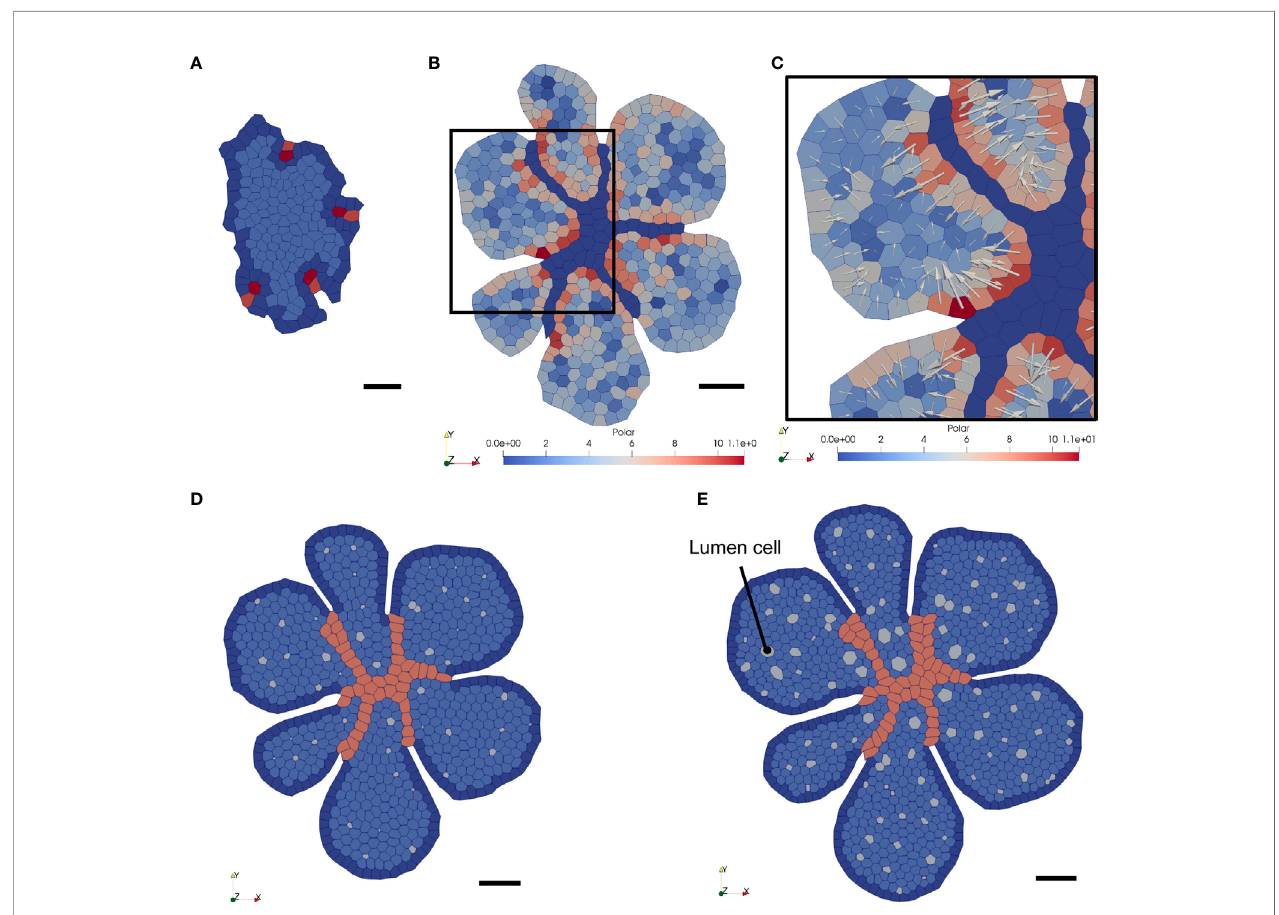
FIGURE 7 | Snapshots of the VM simulation of epithelial polarisation and lumen formation in the growing thyroid epithelial sheet invaded by endothelial cells. (A) Initial con fi guration of the thyroid VM (t = 0h). Same as Figure 5A . No cell is polarised at that stage. (B) Con fi guration at simulation time t = 24h. Endothelial vessel network is in dark blue. Degree of epithelial cell polarisation can be visualised with the colour scale (blue, not polarised to red, polarised). (C) Close-up view of (B) with polarity vectors (white arrows) representing polarisation state for each epithelial cell. (D) Con fi guration at t = 48h. Small lumina can be observed within each of the epithelial islets. Epithelial cells keep on proliferating despite a progressive reduction in proliferation rate (see Figure 3E ). (E) Con fi guration at t = 72h. More lumina have developed within the fragmented epithelial sheet, and lumina size continued to expand since more epithelial cells polarise. On the contrary, epithelial cell proliferation continued to decline, and expansion is thus